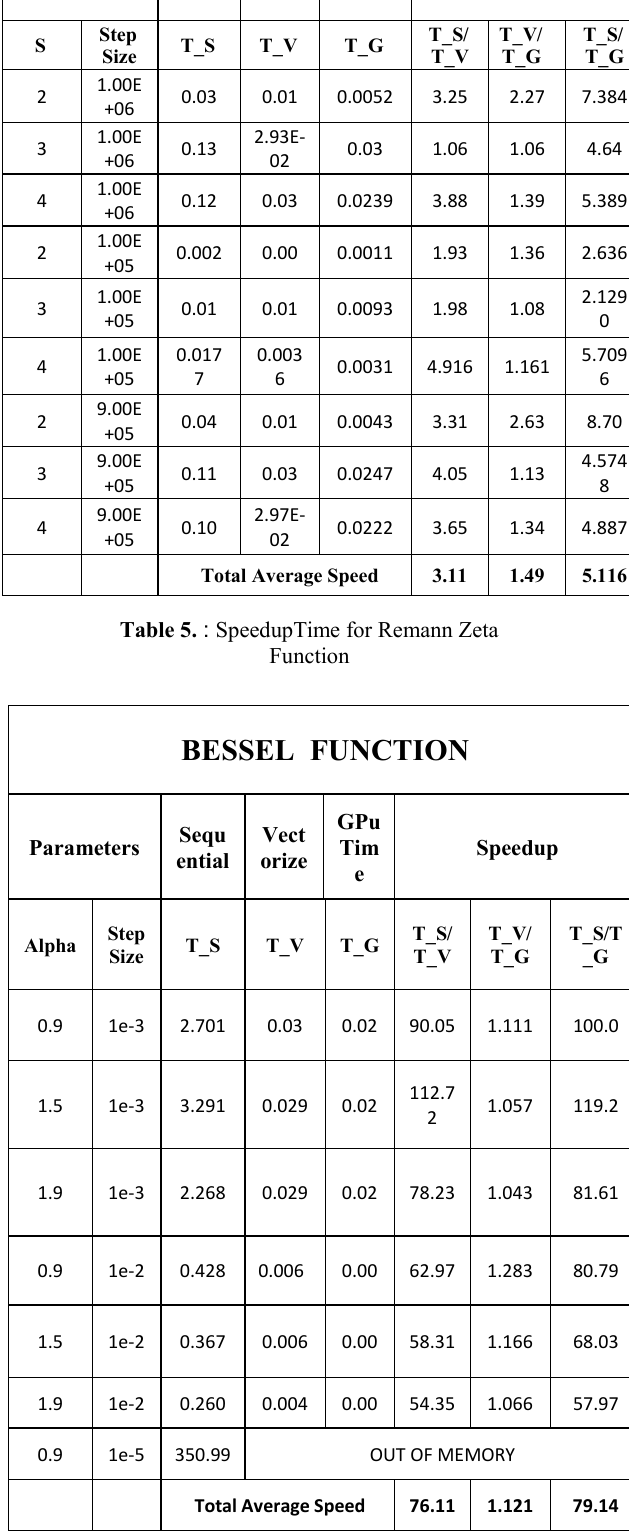
Table 6. : Speedup Time for Bessel